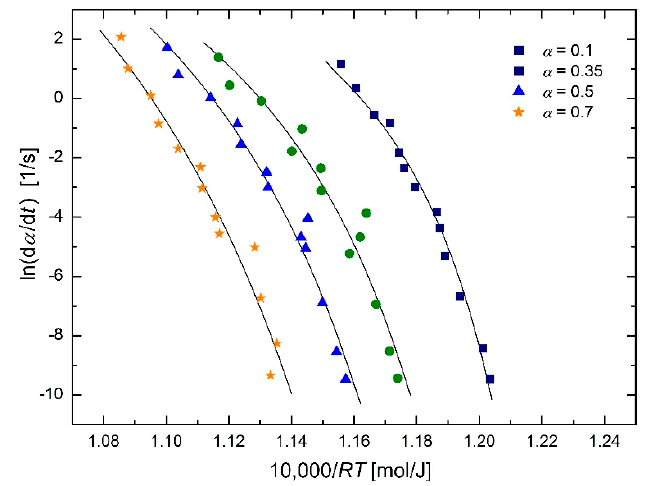
Figure 7. Arrhenius plot for austenitization of SA 508 Gr.3 steel using isoconversional method [2] (reduced data) based on the modified Arrhenius equation in the form of Equation (27), with common regression parameter T 0 for all α values.